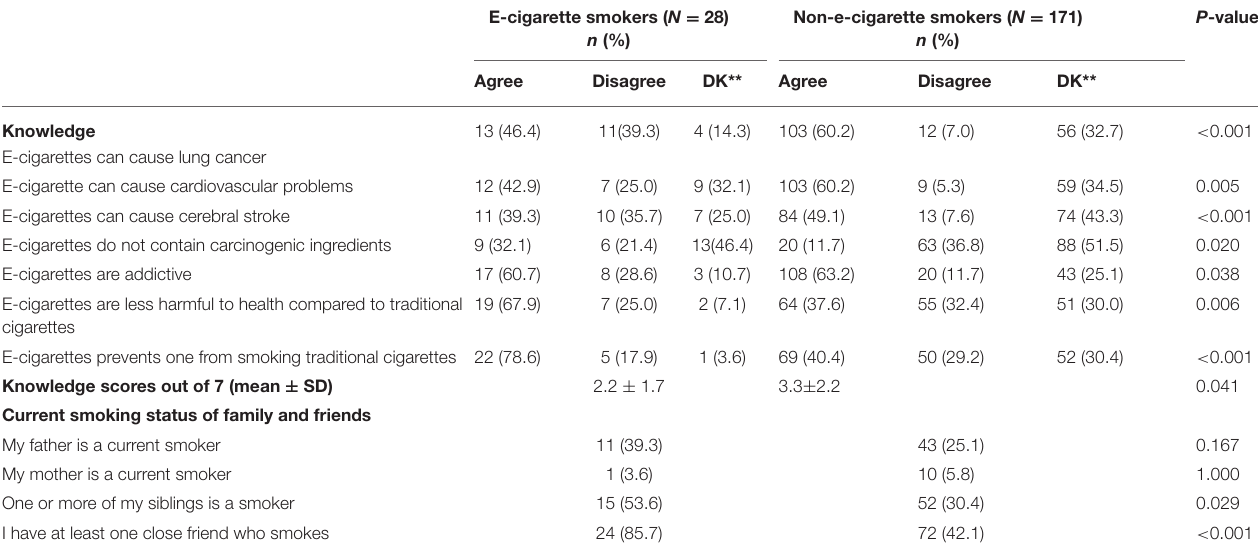
TABLE 4 | Knowledge and smoking status of family and friends, by e-cigarette use.